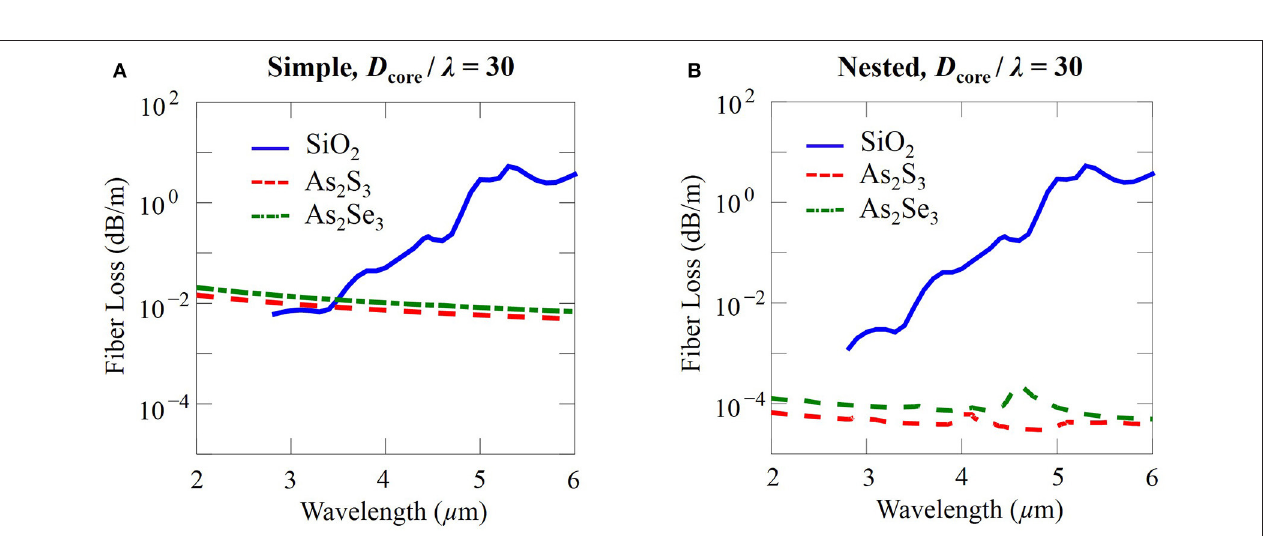
FIGURE 11 | Fiber loss of (A) simple and (B) nested negative curvature fibers made with silica, As 2 S 3 chalcogenide, and As 2 Se 3 chalcogenide glasses with D core / λ = 30.